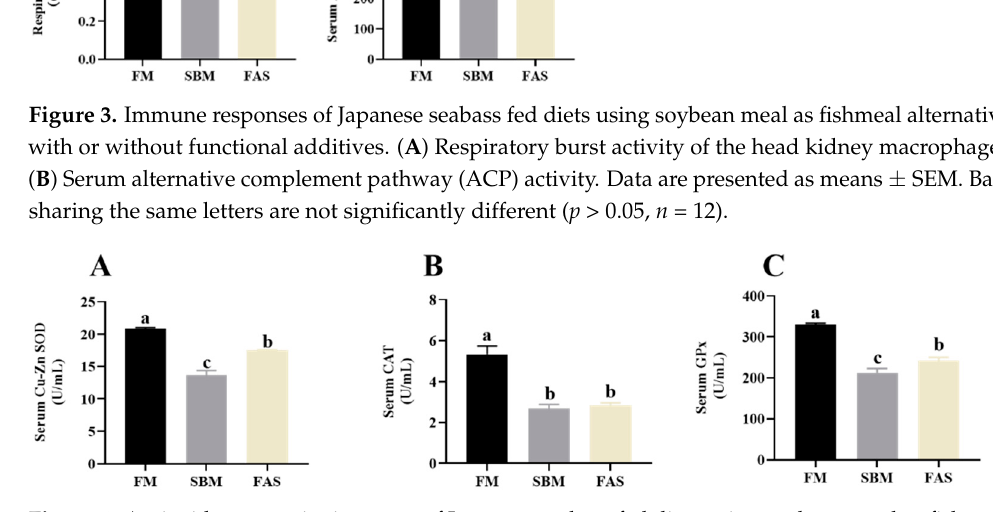
Figure 4. Antioxidant capacity in serum of Japanese seabass fed diets using soybean meal as fishmeal